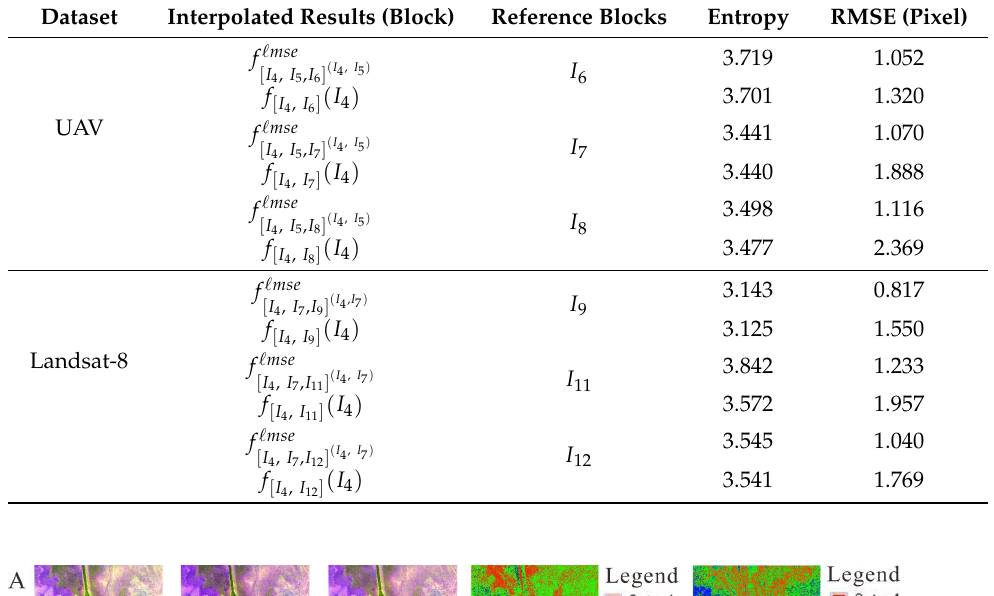
Table 4. Quantitative comparison between block interpolated result and reference block using our proposed method and method of Meyer et al. on both datasets.